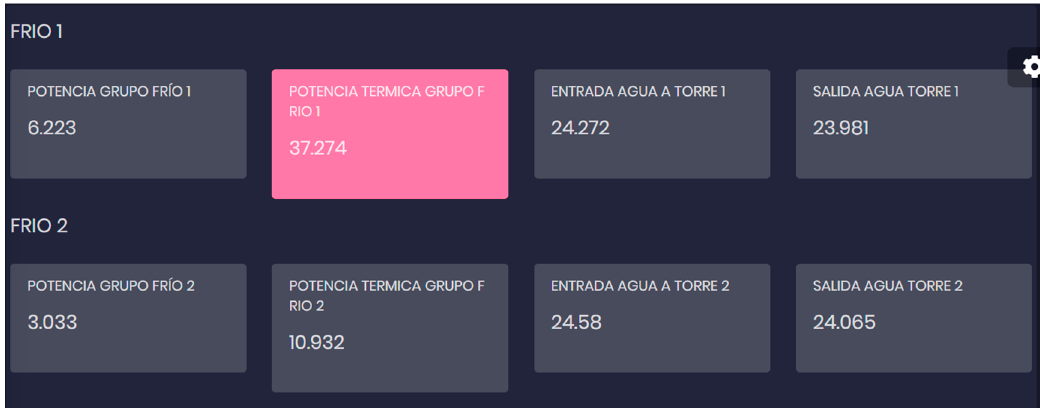
Figure 10. An example with an abnormal value highlighted.